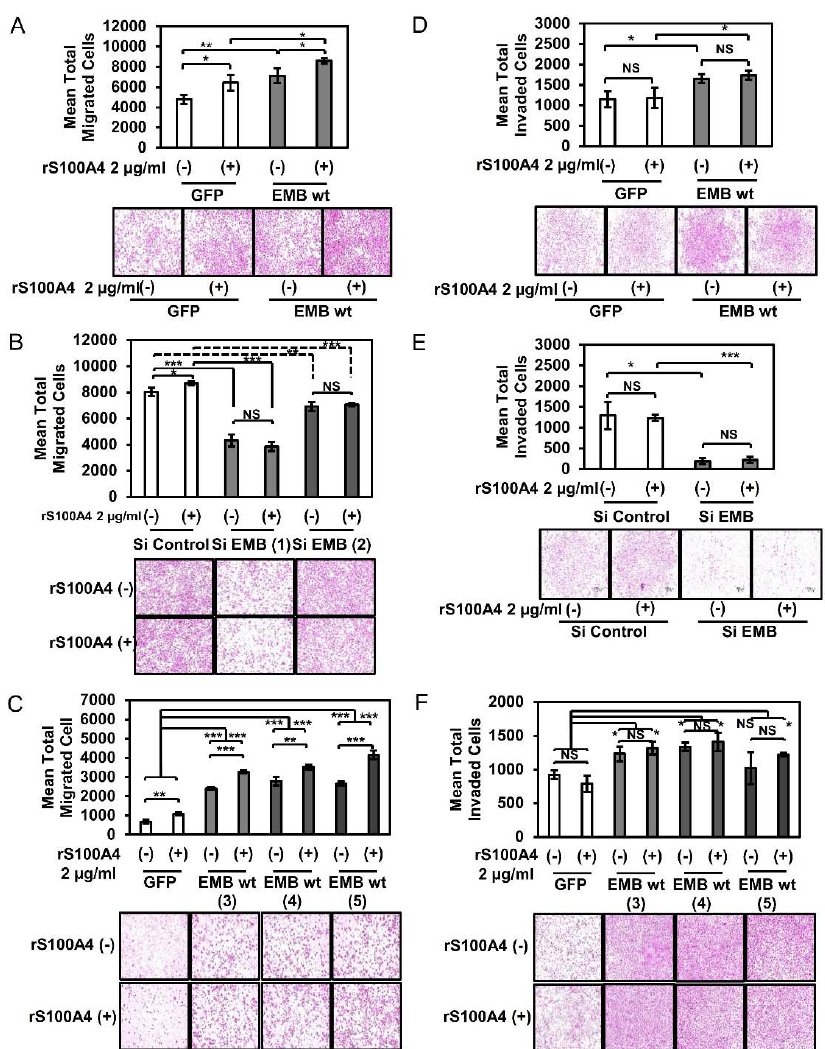
Figure 2. S100A4 binding to embigin augments migration ability of prostate cancer cells. ( A – C